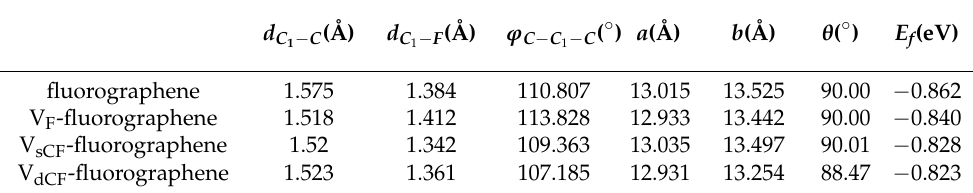
Table 1. The structural data including lattice information, average bond length ( d C d C ), average angle between adjacent C 1 –C ( ϕ C − C 1 − F V F -, V sCF -, and V dCF -fluorographene. C 1 is the nearest neighbor C atoms of vacancy defects. E f = ( E total − mE C − nE F ) / n tot , where E C and E F are the energy of C and F atom obtained from diamond and F 2 , respectively. The m and n represent the numbers of the C and F